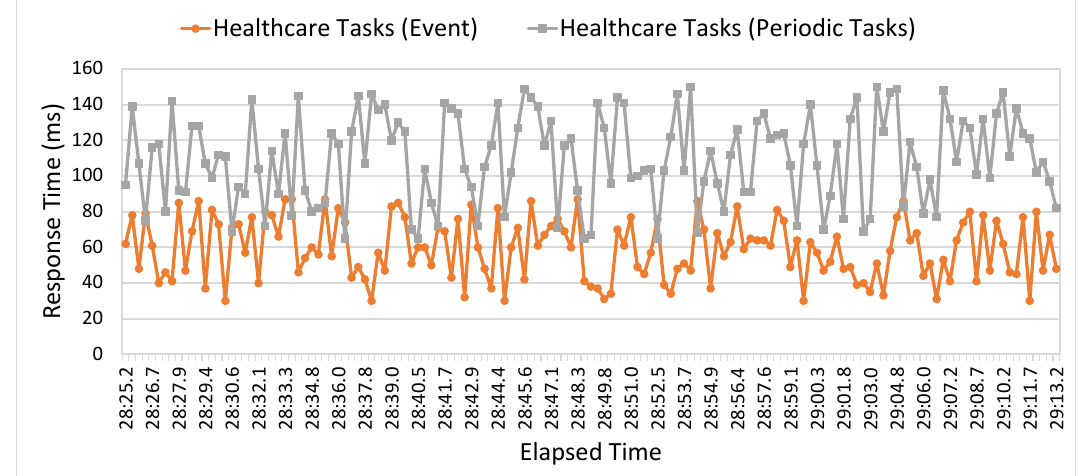
Figure 10. Performance analysis of event and periodic healthcare tasks in terms of Response Time.